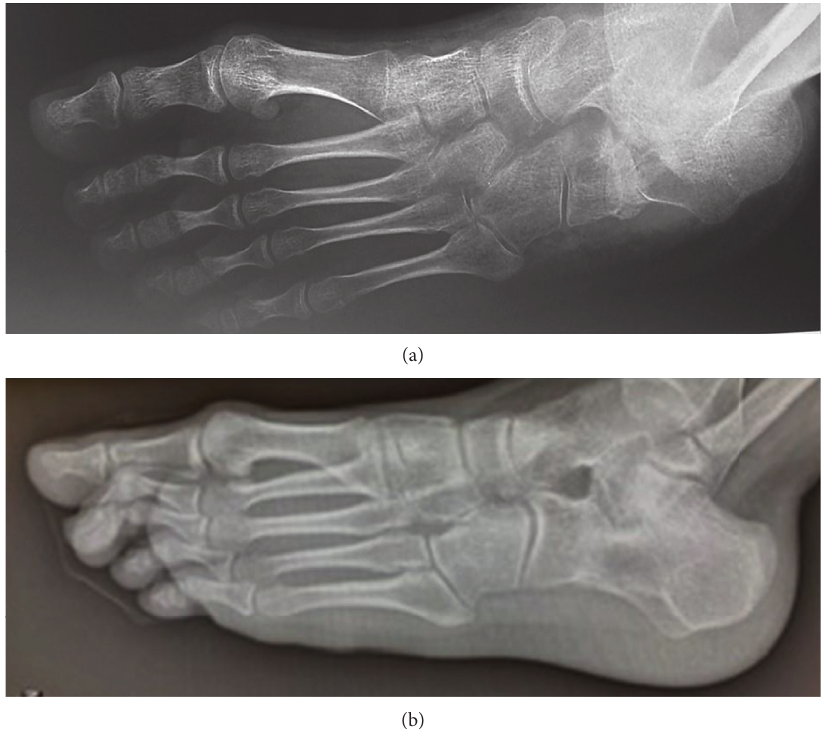
Figure 2: Same patient of Figure 1, three years later. The patient was surgically treated by Evans–Mosca procedure bilaterally with an interval of six months. The radiographic examination of the left foot, performed in oblique view 3 months after surgery, showed good lengthening of the calcaneus with the presence of the tricortical bone graft (a). At an intermediate follow-up, 7 years later, the graft was perfectly remodeled in the calcaneal bone with the maintenance of calcaneal lengthening and without any sign of osteoarthritis of the calcaneocudoid joint